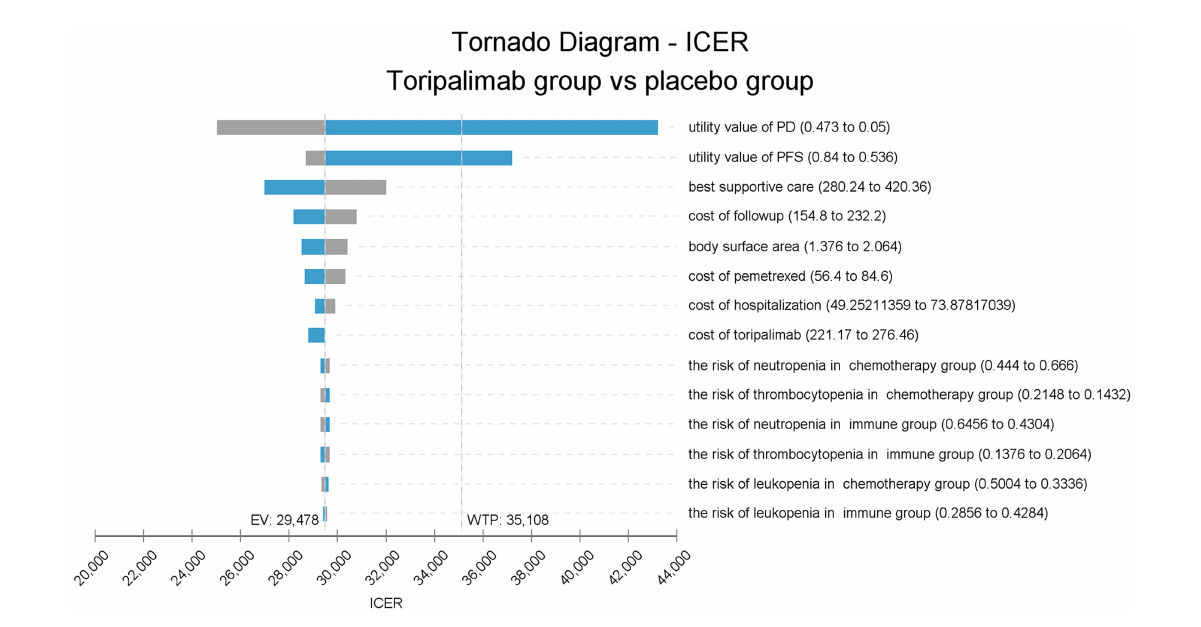
FIGURE 2 Tornado diagram of one-way sensitivity analysis. ICER, incremental cost-effectiveness ratio; placebo group, placebo + chemotherapy; toripalimab group, toripalimab + chemotherapy; PFS, progression-free survival; PD, progressive disease; EV, expected value; WTP,